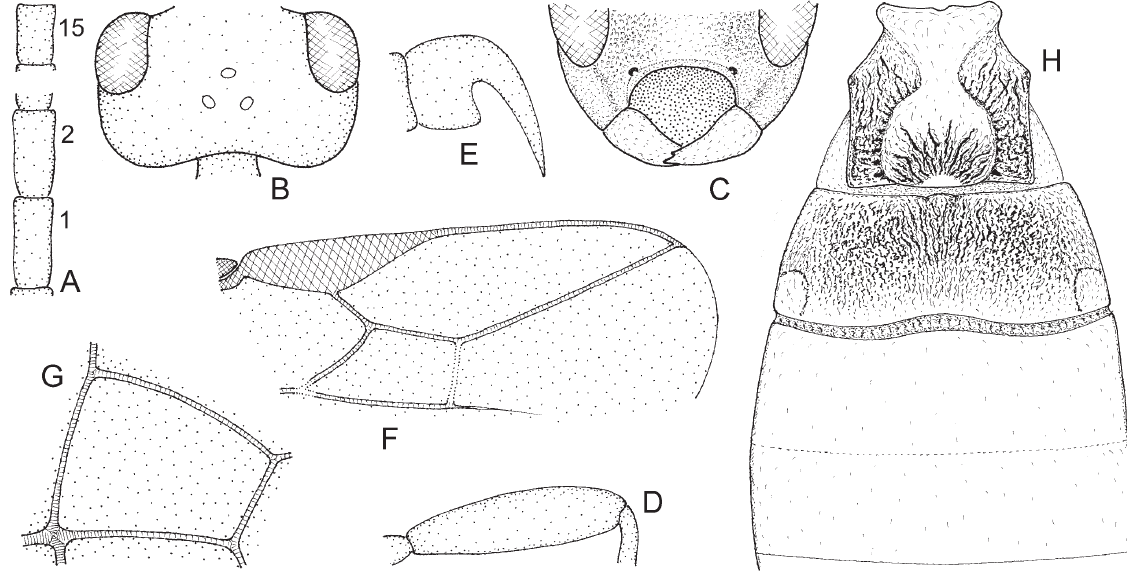
Fig. 13. Bracon ( Lucobracon ) guttiger Wesmael, 1838, ♀ lectotype. A . Flagellomeres 1-2 and 15. B . Head in dorsal view. C . Head in frontal view. D . Hind femur. E . Claw. F . Distal part of right forewing. G . First discal cell of right forewing. H . Tergites